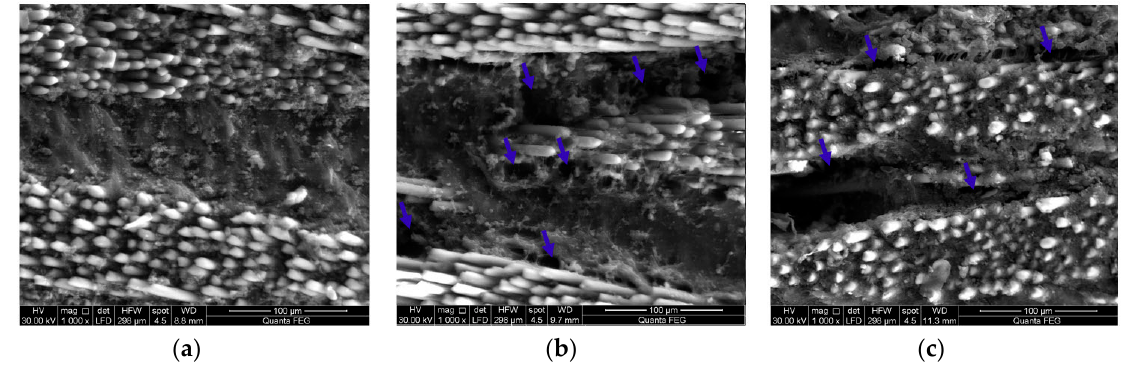
Figure 17. FESEM images for ( a ) dry MWCNTs/GFRP; ( b ) MWCNTs/GFRP after 100 days exposure at 22 °C and ( c ) MWCNFTs/GFRP after 100 days exposure at 45 °C. The blue arrows mark some micro-cracks in the matrix.